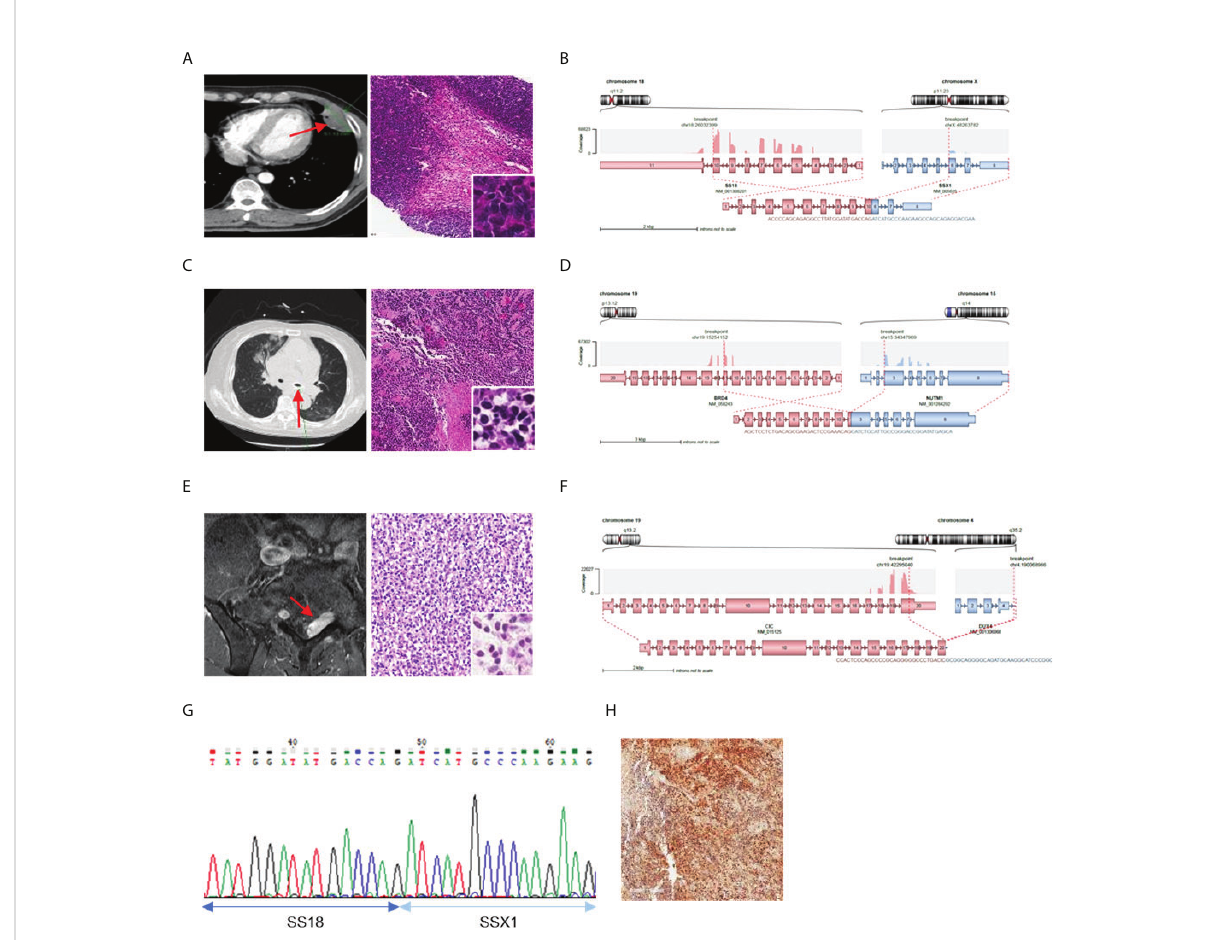
FIGURE 2 Cases with complemented diagnosis through targeted sequencing. (A) Chest computed tomography image of 47mm sized pleura based soft mass lesion (left) and H&E staining of tissue diagnosed with Ewing sarcoma (right). (B) Schematic of the SS18-SSX1 fusion. (C) CT image of mediastinum (left) H&E staining of tissue diagnosed as undifferentiated carcinoma (right). (D) Schematic of the BRD4-NUTM1 fusion. (E) Magnetic resonance imaging of spine (left) and H&E staining of tissue diagnosed undifferentiated small round cell (right). (F) Schematic of the CIC-DUX4 fusion (G) Con fi rmation of SS18-SSX1 fusion with RT-PCR and Sanger sequencing. (H) NUT IHC. *Red arrows indicated tumor